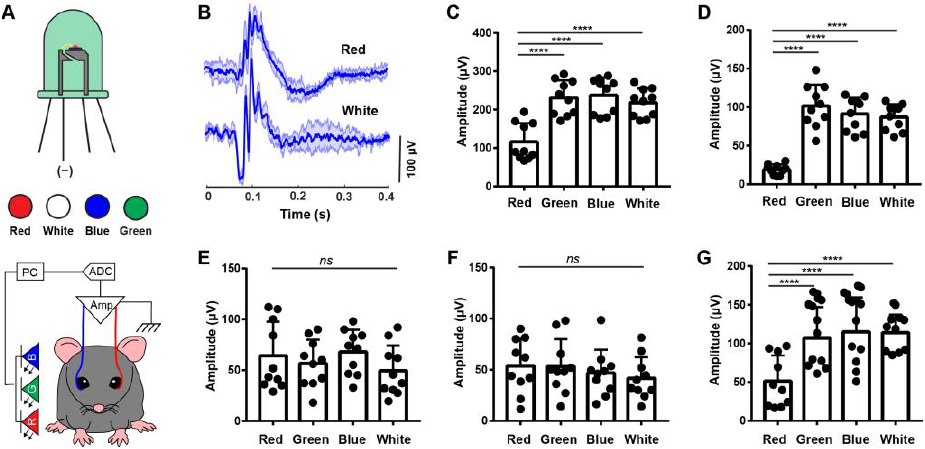
Figure 2. Scotopic flash ERG responses under different color light stimulation. ( A ) Schematic illustration of ERG recording system with an RGB LED light source. ( B ) Representative scotopic flash ERG waveforms under red- and white-light stimulation (solid line: mean, shaded area: s.d., n = 4 independent eye measurements from 2 mice). ( C ) Quantitative comparison of the ERG overall maximum response for different color light stimulations. The amplitude comparison of a-wave ( D ), b-wave ( E ), NR ( F ), and OPs ( G ) from the scotopic flash ERG responses under red-, green-, blue-, and white-light stimulations. N = 10 eyes. PC, personal computer; ADC, analog-to-digital converter; Amp, amplifier. ns: not significant. **** p < 0.0001.